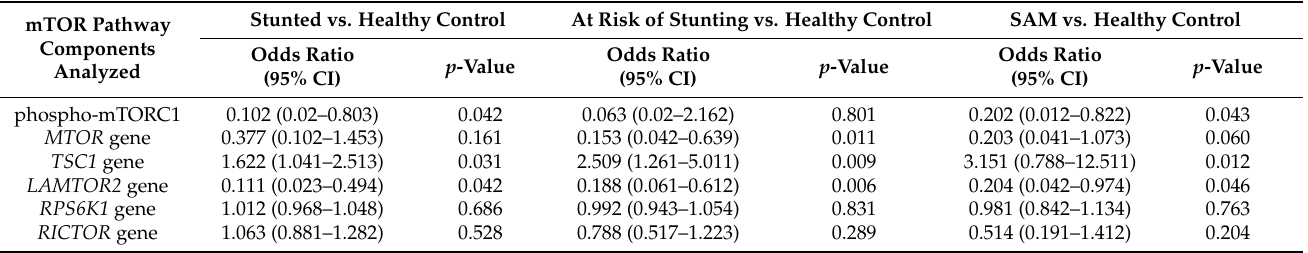
Table 3. Association of the analyzed mTOR pathway components with the different forms of childhood malnutrition; results from multivariate logistic regression